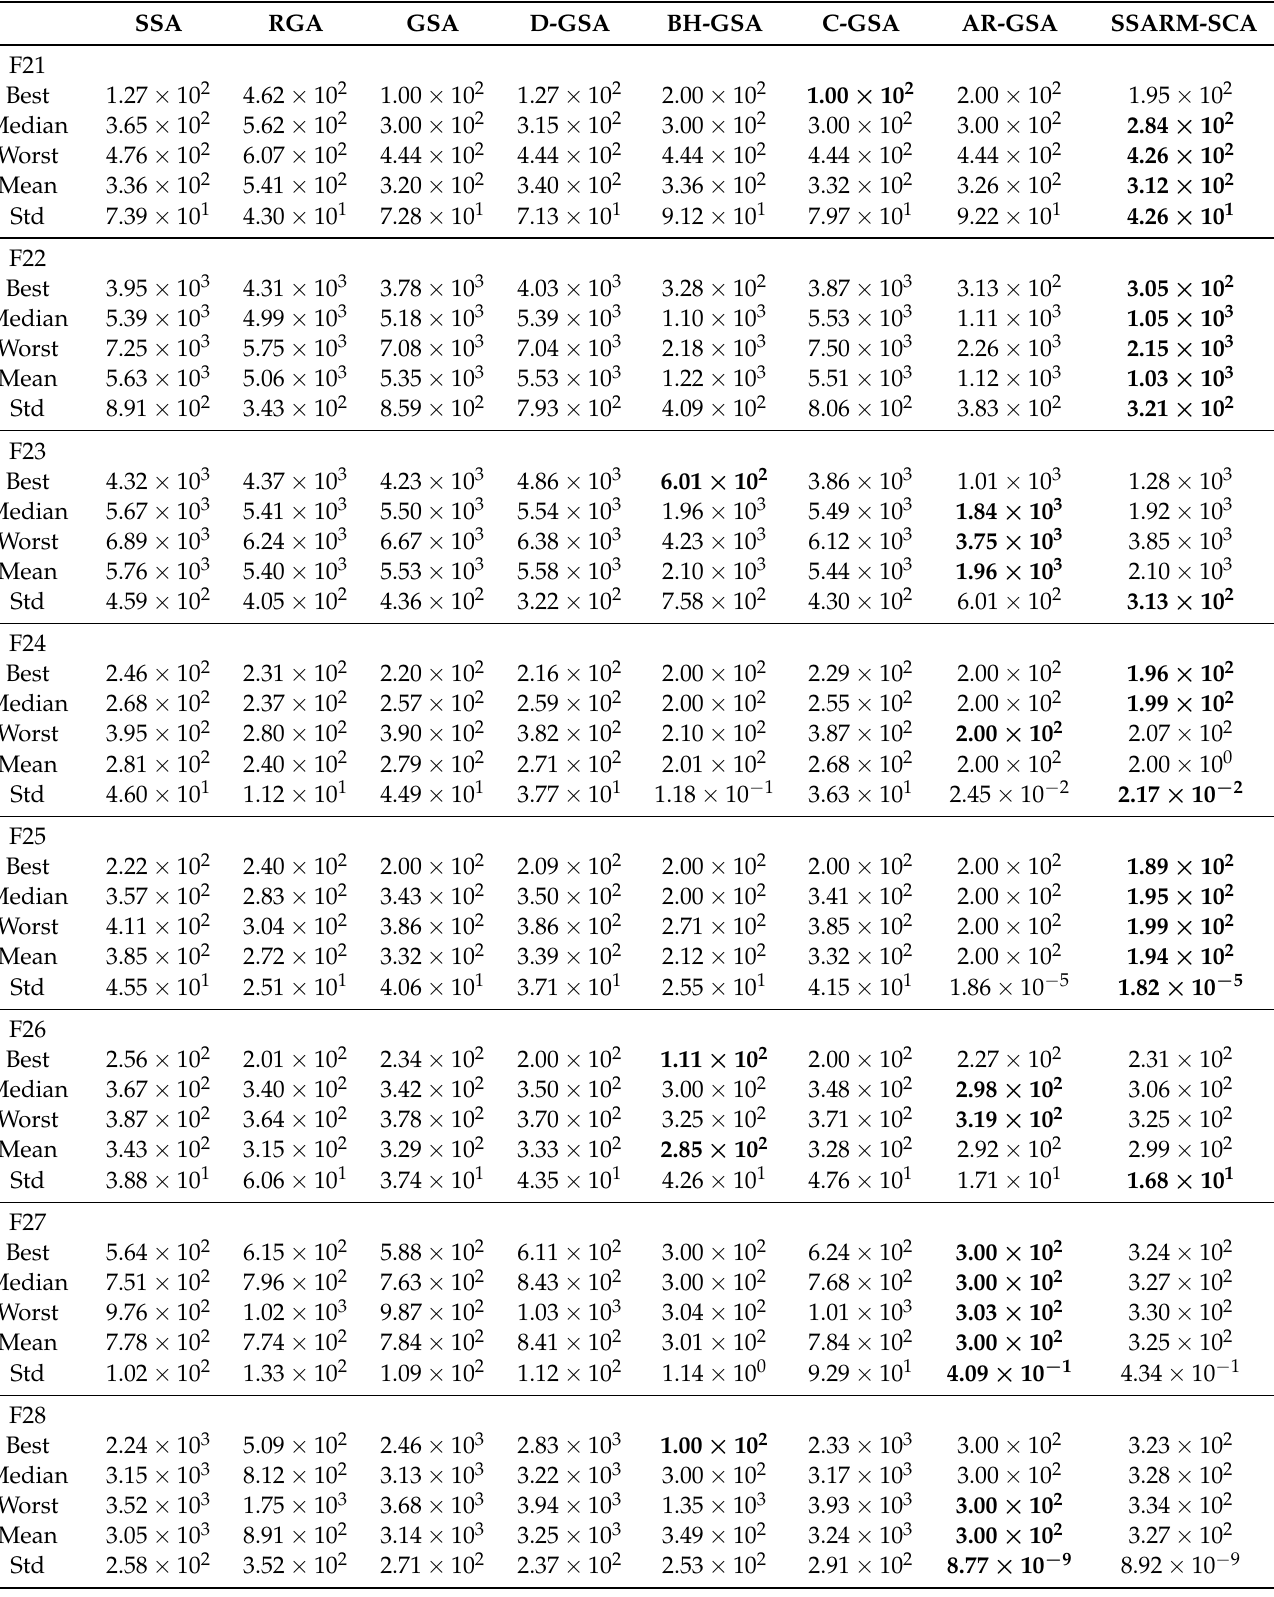
Table 4. Comparative analysis between SSARM-SCA and other SOTA methods for CEC2013 compos- ite